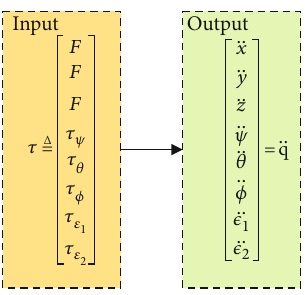
Figure 2: Inputs and outputs of the aerial